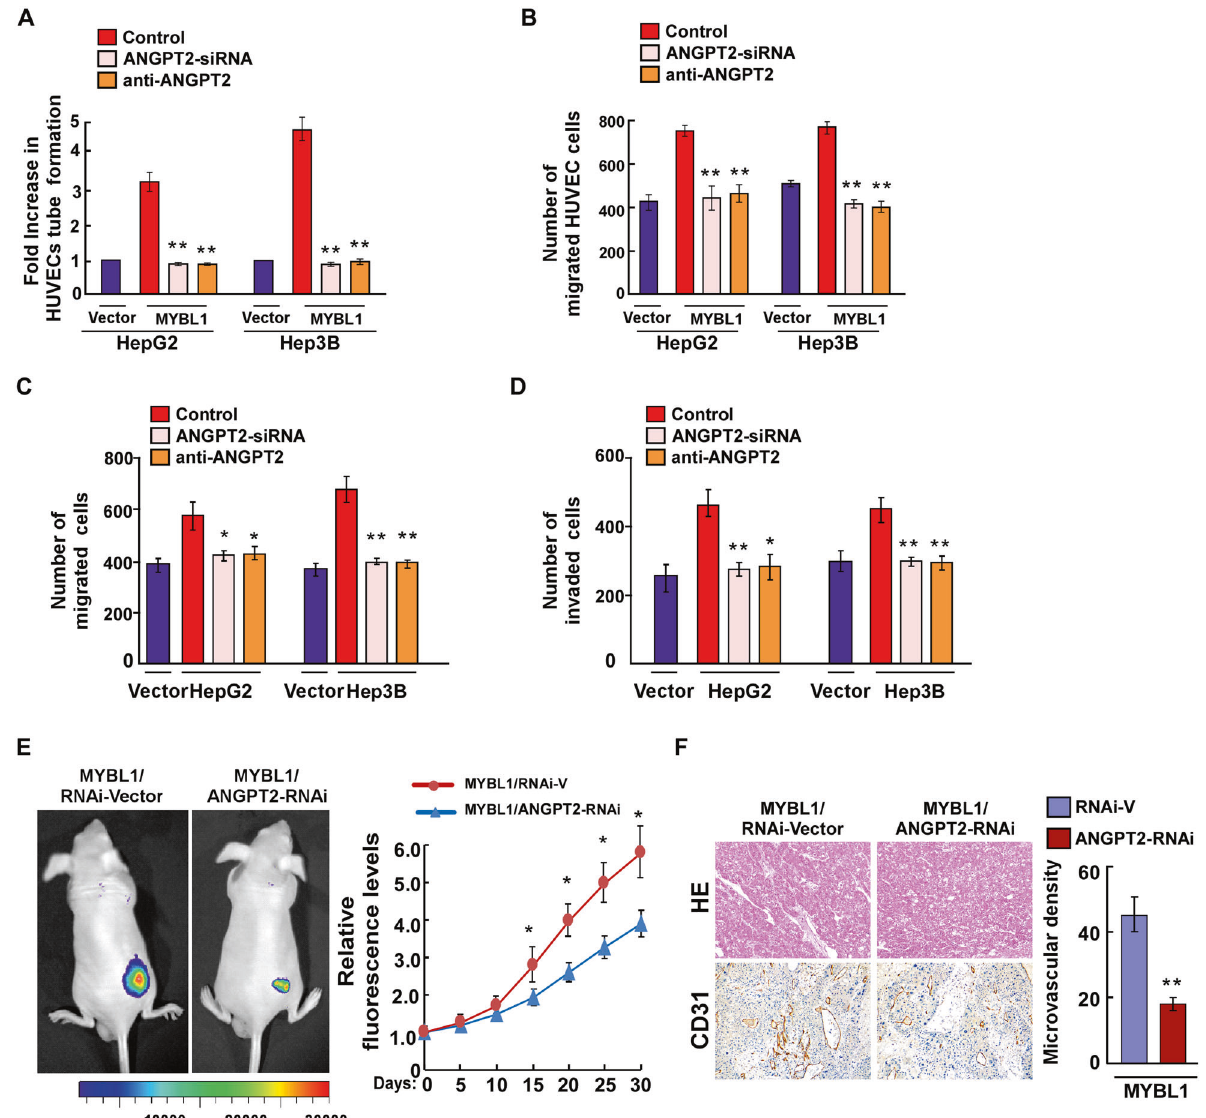
Fig. 5 ANGPT2 is required for MYBL1-induced angiogenesis. A Quanti fi cation of HUVEC tube formation in the indicated group. B Cell migration assay was performed by culturing HUVEC with conditioned media derived from MYBL1-transduced HCC cells transfected with ANGPT2 siRNA or treated with a neutralizing anti-ANGPT2 antibody. C Quanti fi cation of indicated migration HCC cells by transwell assays. D Quanti fi cation of indicated invasion HCC cells by transwell assays. E Relative fl uorescence signal of nude mice was measured on the indicated group. F H&E and IHC staining analyses the CD31 expression in the indicated group. Each bar represents the mean ± SD of three independent experiments. * P < 0.05, ** P <